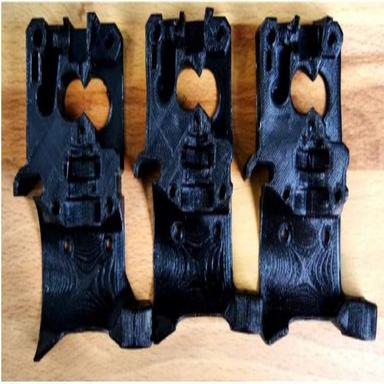
Annealed FDM prints at (a) 40 C, (b) 60 C and (c) 80 C.